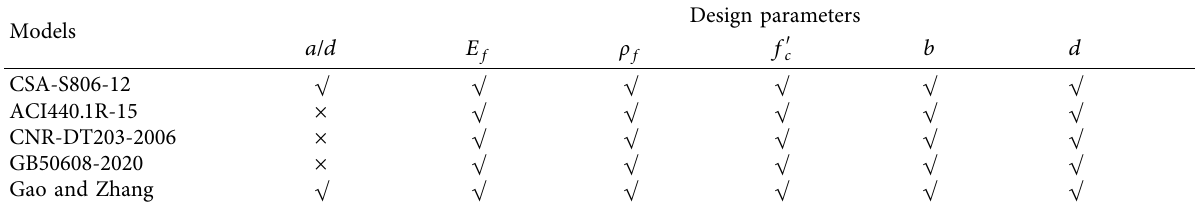
Table 2: Factors considered in the